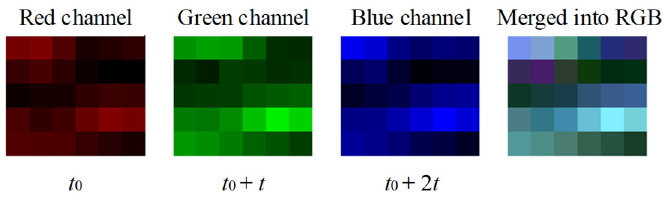
Figure 5. An example for merging the instances corresponding to the same fragment with a time interval t into one RGB image.